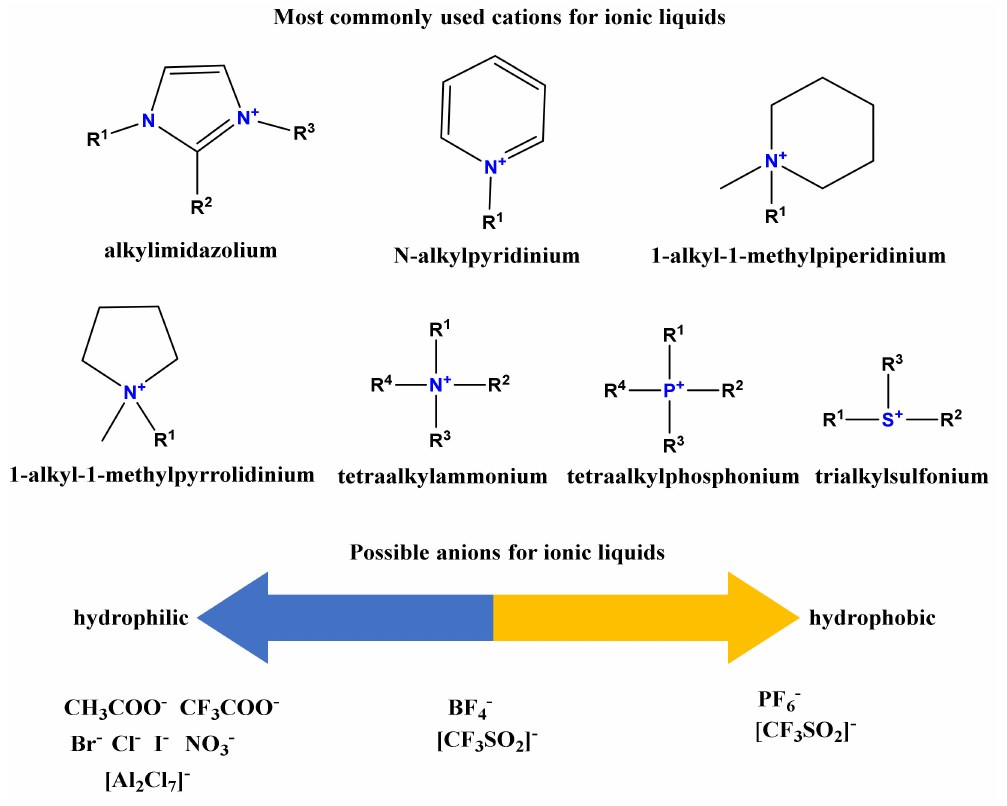
Figure 4. Possible cations and anions for ionic